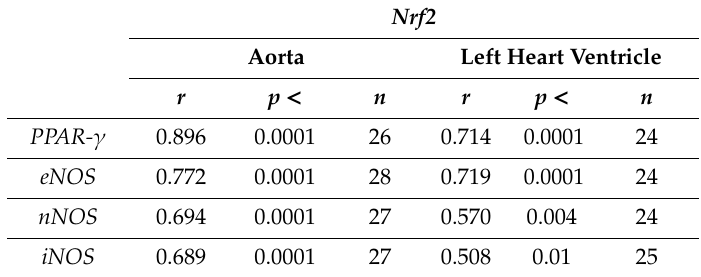
Table 3. Correlations between the gene expressions in the aorta and left heart ventricle.